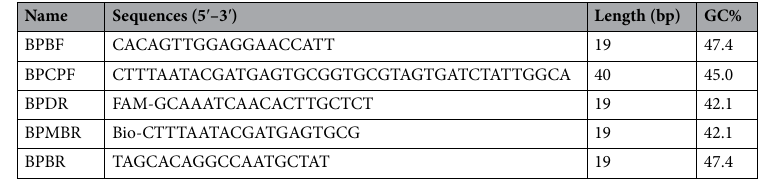
Table 1. The primer set S1 screened with high efficiency in the RT-CPA-LFD assay for BPMV